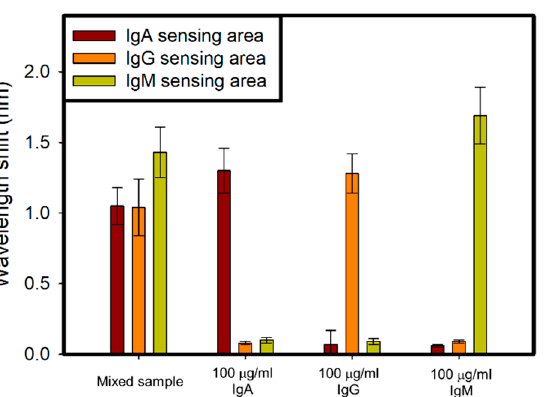
Figure 7. Sample test including 100 µg/mL IgA, IgG, IgM, and mixing sample of IgA, IgG, and IgM with raito of 1:1:1.